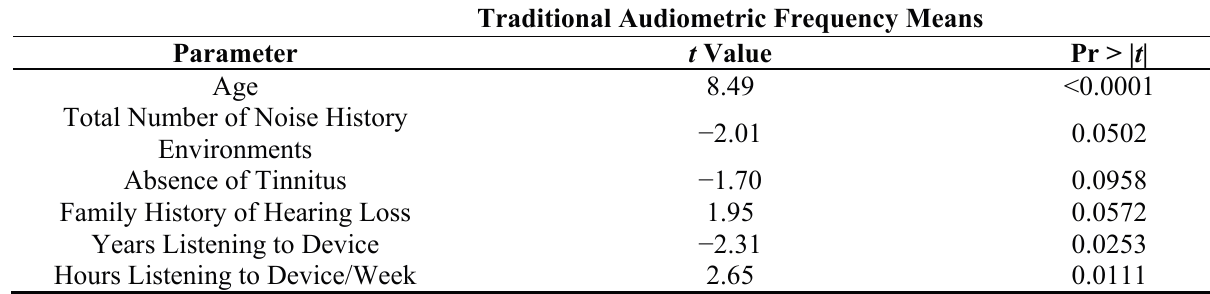
Table 3. Variables contributing to wideband pure tone means for PLD users.